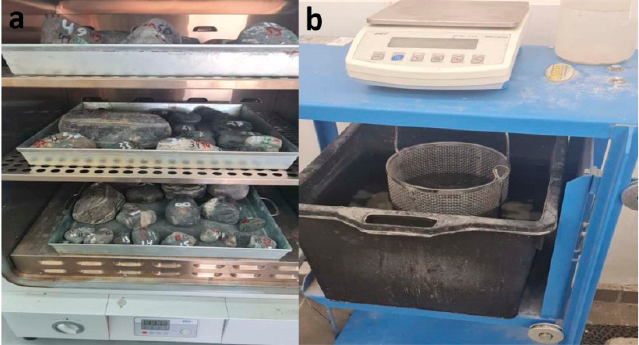
Figure 5. ( a ) The oven-drying; ( b ) the tool for the density measurement by Archimedes method.